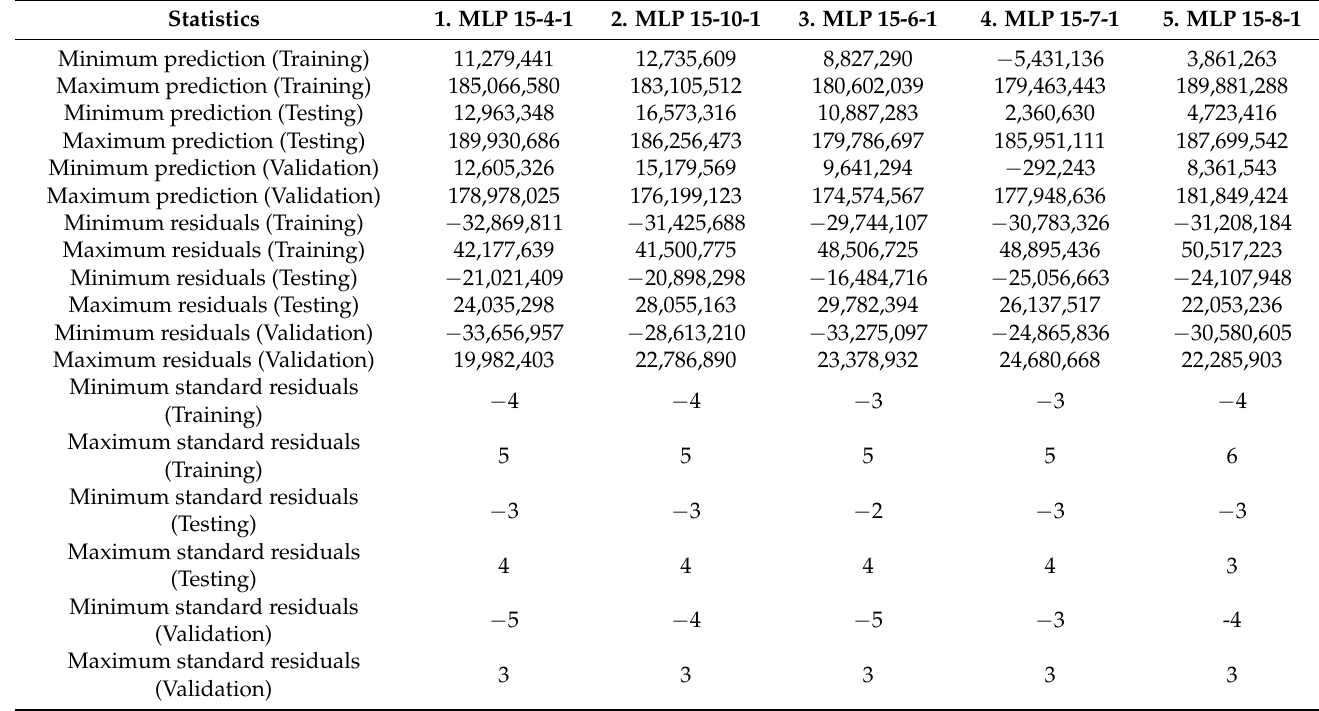
Table A3. Basic statistics of equalized time series—5-month